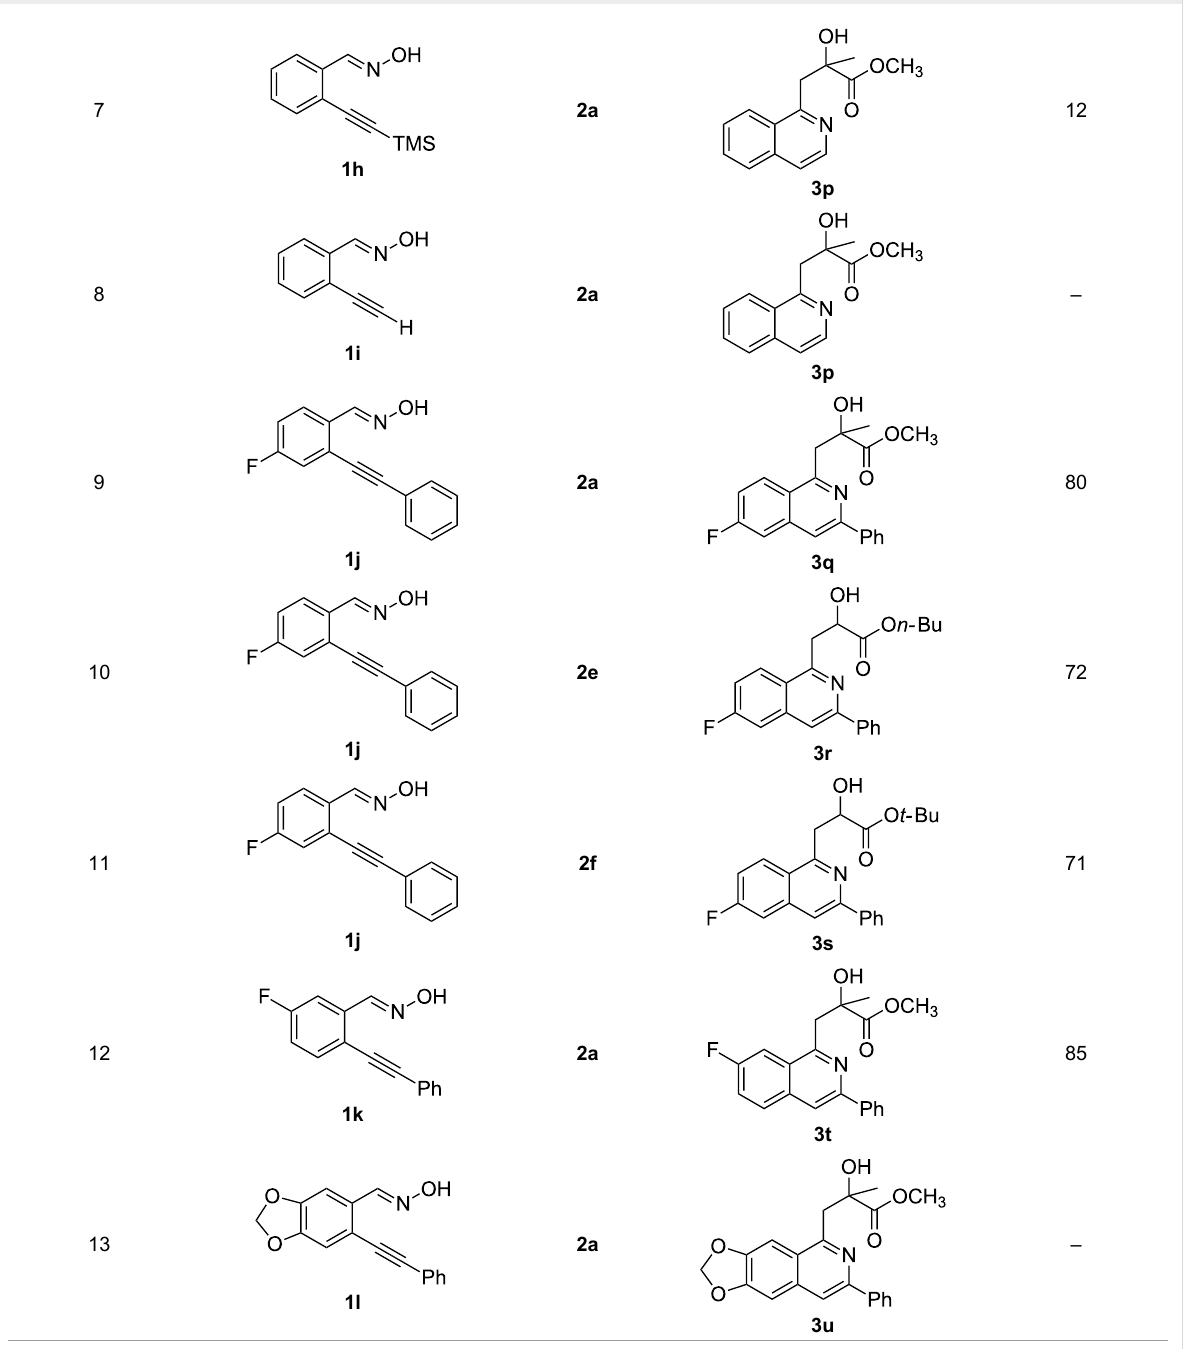
Table 2: One-pot reactions of 2-alkynylbenzaldoximes 1 with acrylates 2 .